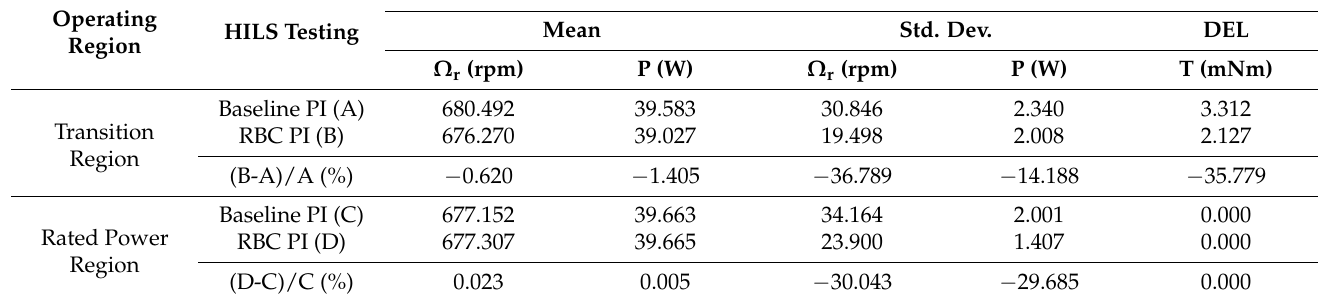
Table 4. Quantitative comparison of control performance for scaled wind turbine model during HILS